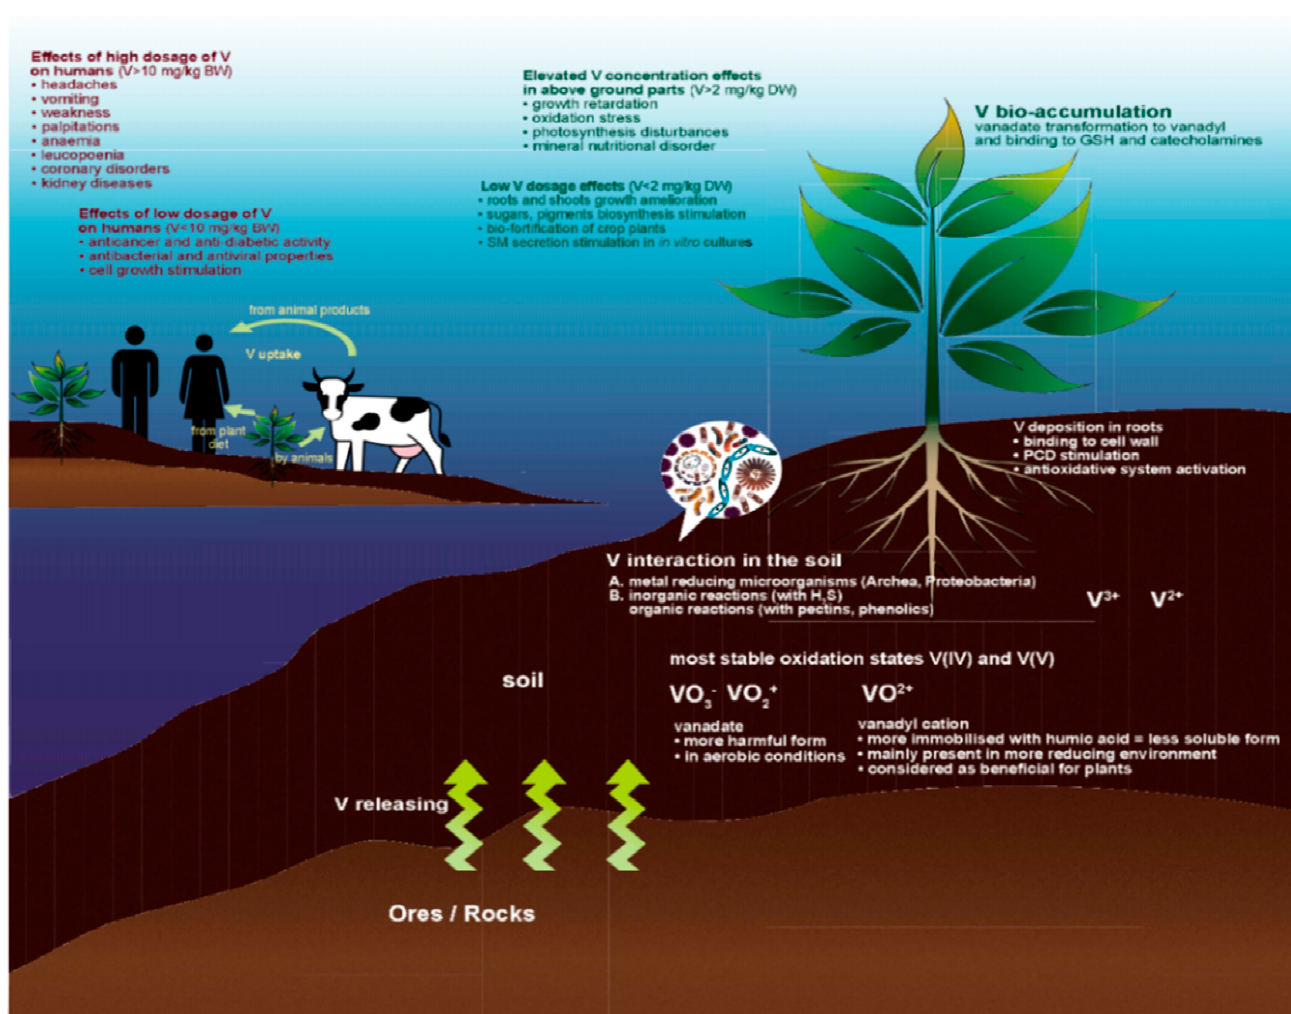
Figure 1. Vanadium circulation in the environment and main beneficial and detrimental effects on plants and humans. (1) V transformation within the soil and roots—marked with white font; (2) V translocation to stems and leaves and its effects on plant physiology—marked with green font; (3) V uptake and its effect on human organism—marked with yellow and brown font; SM—secondary metabolites.